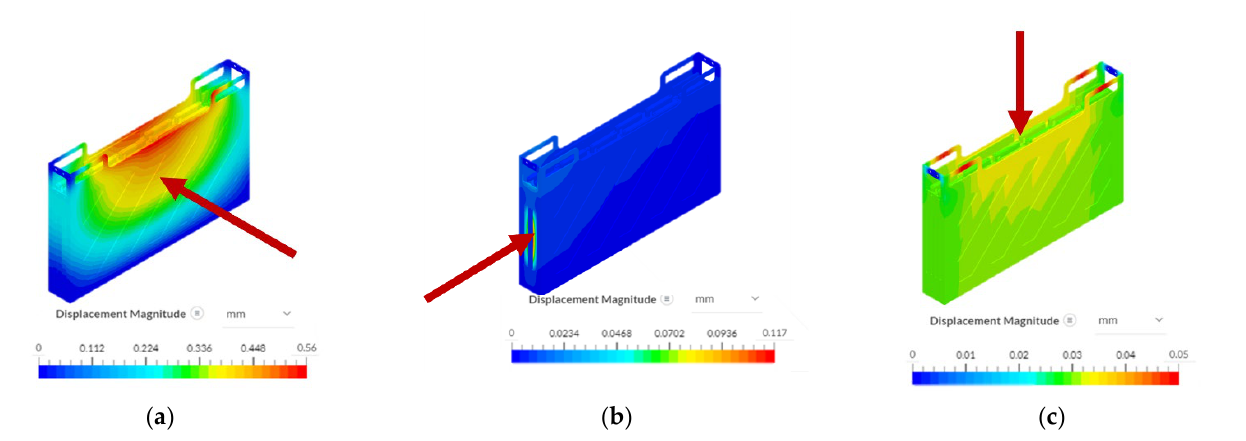
Figure 12. ( a ) Longitudinal deformation. ( b ) Lateral deformation. ( c ) Vertical deformation. The base of the modules is considered as fixed points and load is applied to the module walls.